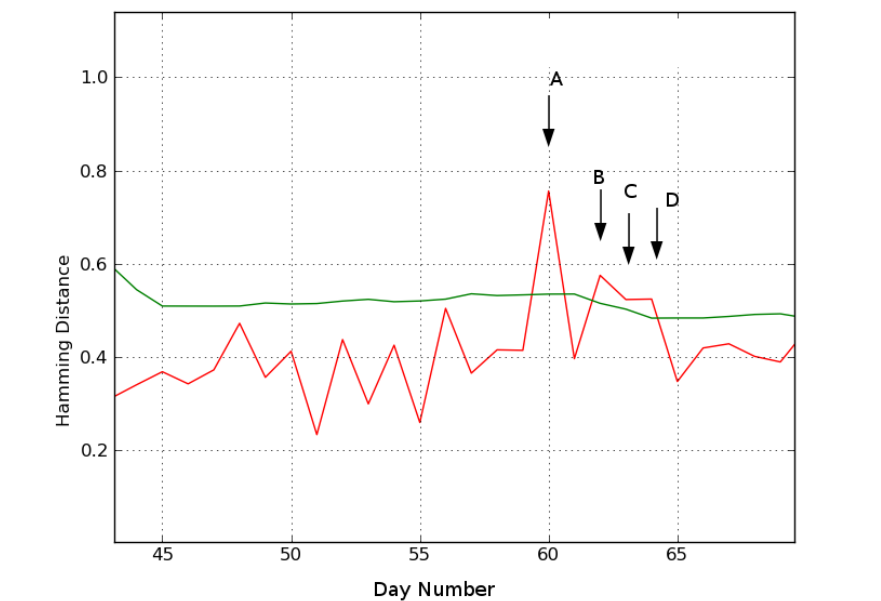
Figure 9. Location 2. Each day’s Hamming distance compared to its reference day using n = 21 days and τ = 60 s. The green line is the threshold calculated by Equation (2). Distances exceeding the threshold are indicated by an arrow and represent a deviation (green line is calculated threshold, red line is hamming distance). ‘A’, ‘B’, ‘C’, ‘D’ indicate detected deviating days. Location 3. Finally, Figure 10 shows the results for location 3, where only day 44 (A) is considered deviating. Day A’s video reveals that the subject leaves her residence in the afternoon for a substantially longer period than in her recent history, which is not strictly an indication of any abnormal behavior.